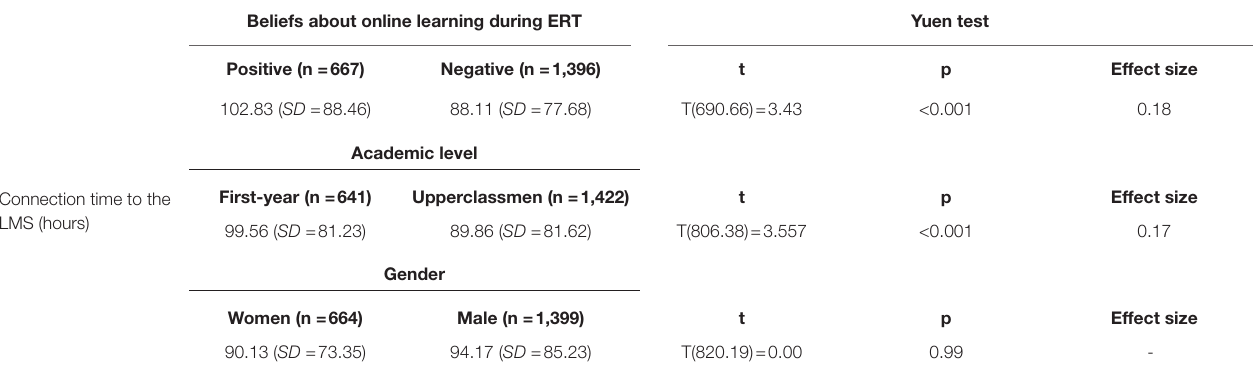
TABLE 1 | Differences in students’ platform times as a function of student learning beliefs, gender, and academic year to which they belong. Beliefs about online learning during